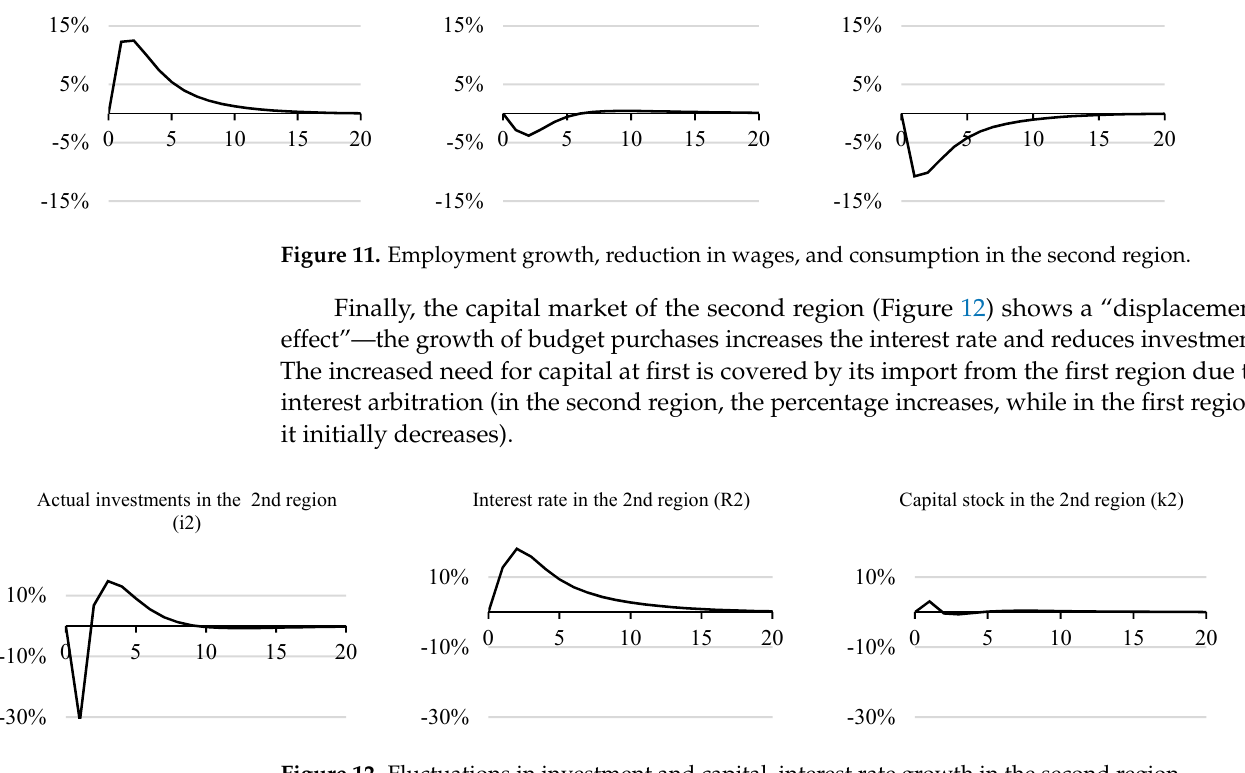
Figure 12. Fluctuations in investment and capital, interest rate growth in the second region. Elasticities (maximum) per unit change of other shocks are presented in Table 2. Table 2. Elasticities (maximum) per unit change in shocks.